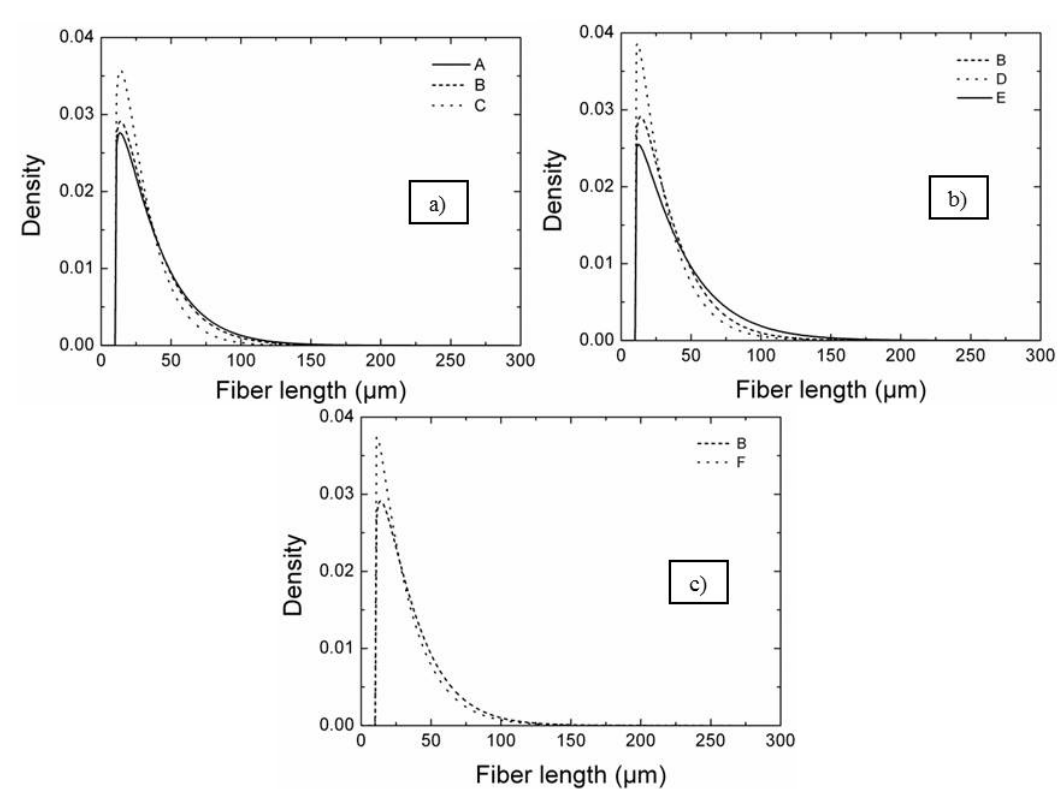
Figure 5. Probability density function curves: ( a ) effect of milling time on the length distribution (sample A, B and C); ( b ) effect of milling velocity (sample B, D and E); ( c ) effect of milling media hardness (sample B and